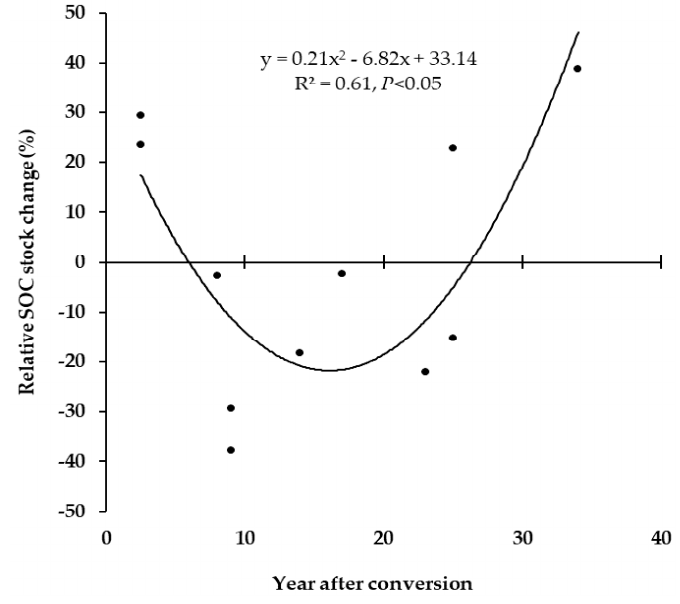
Figure 3. Relative SOC stock change over years after conversion from secondary forest to oil palm plantation (data source: Tables S1–S4) in tropical mineral soils.